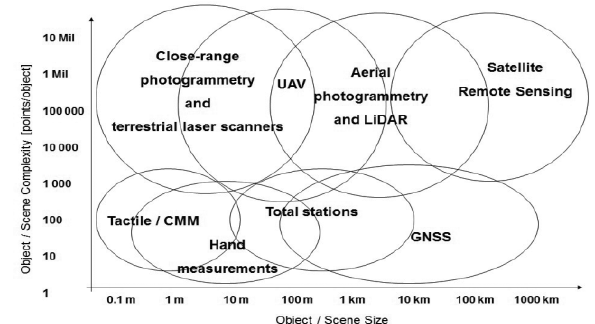
Figure 3. Model reconstruction methods (Remondino,